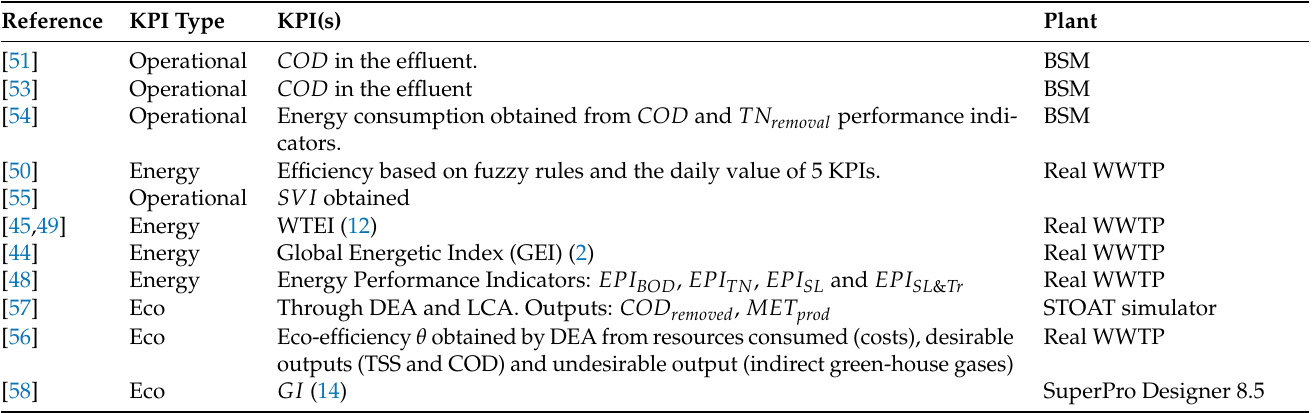
Table 1. Resume of the selected papers related to WWTP KPI-based efficiency